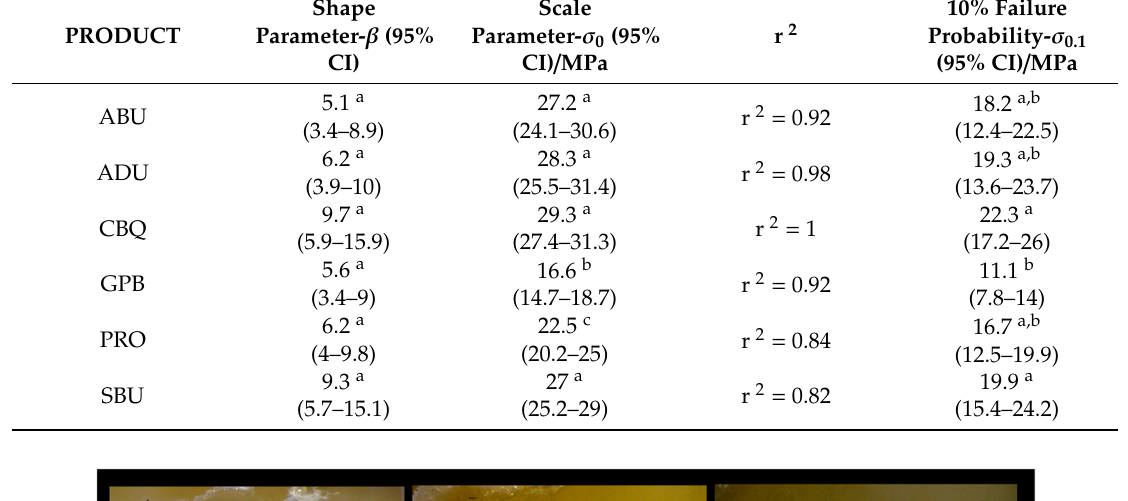
Table 4. The results of the Weibull analysis of the shear bond strength test. Same superscript letters show values with no statistically significant difference between the products per parameter (p > 0.05).